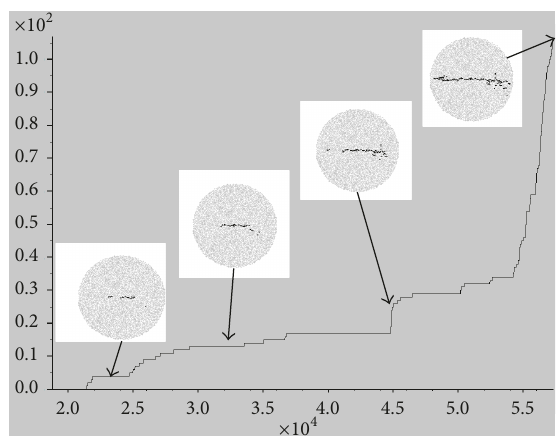
Figure 11: Crack propagation